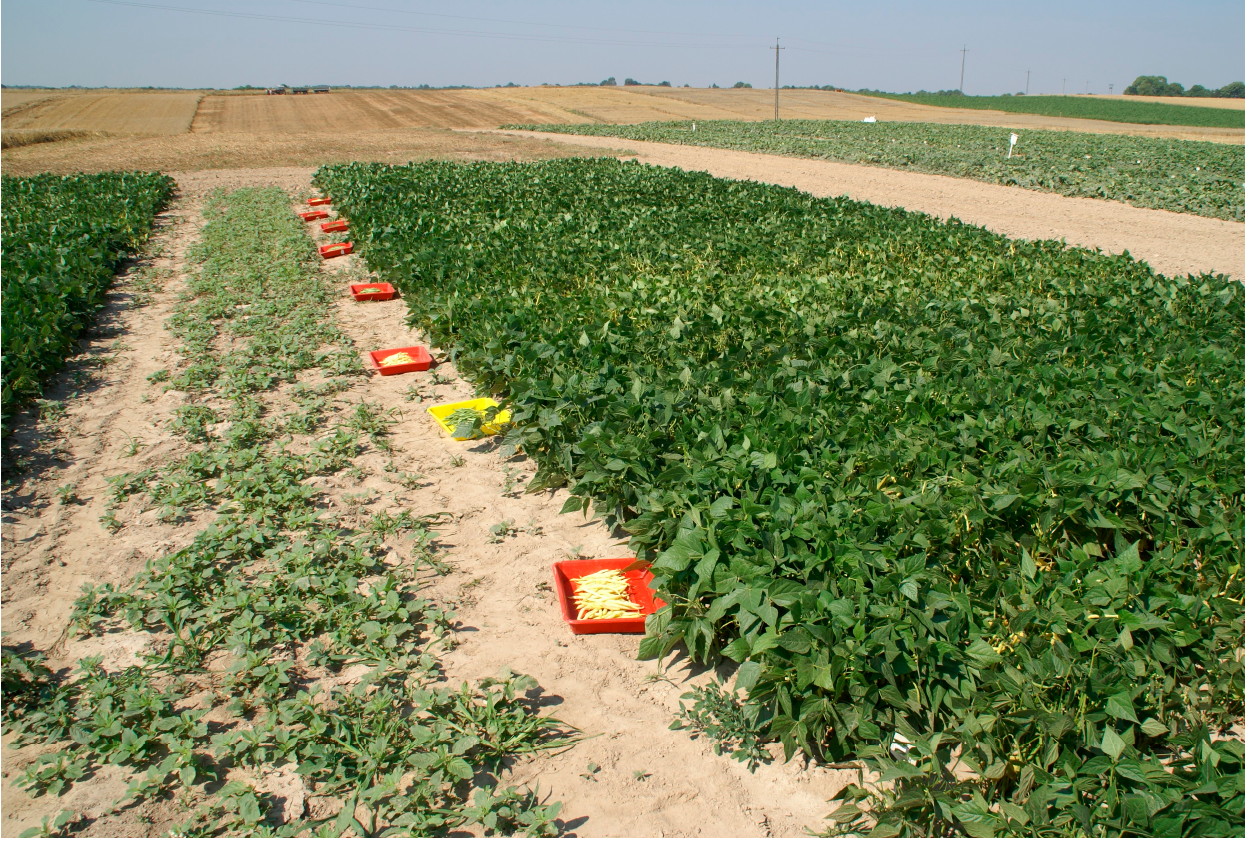
Figure 3. Common beans at harvest at full maturity at BBCH 89 on a 99-point scale. Ż yznów 2017. Source: P. Pszczó ł kowski.